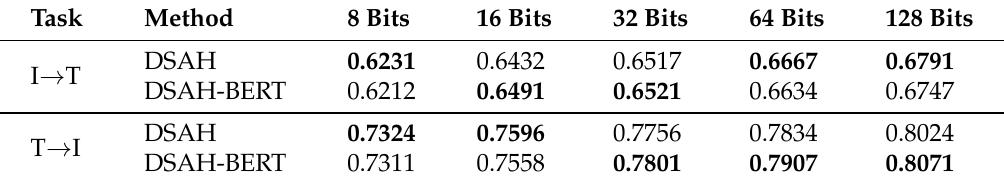
Table 6. mAP scores on NUS-WIDE dataset using BERT and bag-of-word embeddings of DSAH.